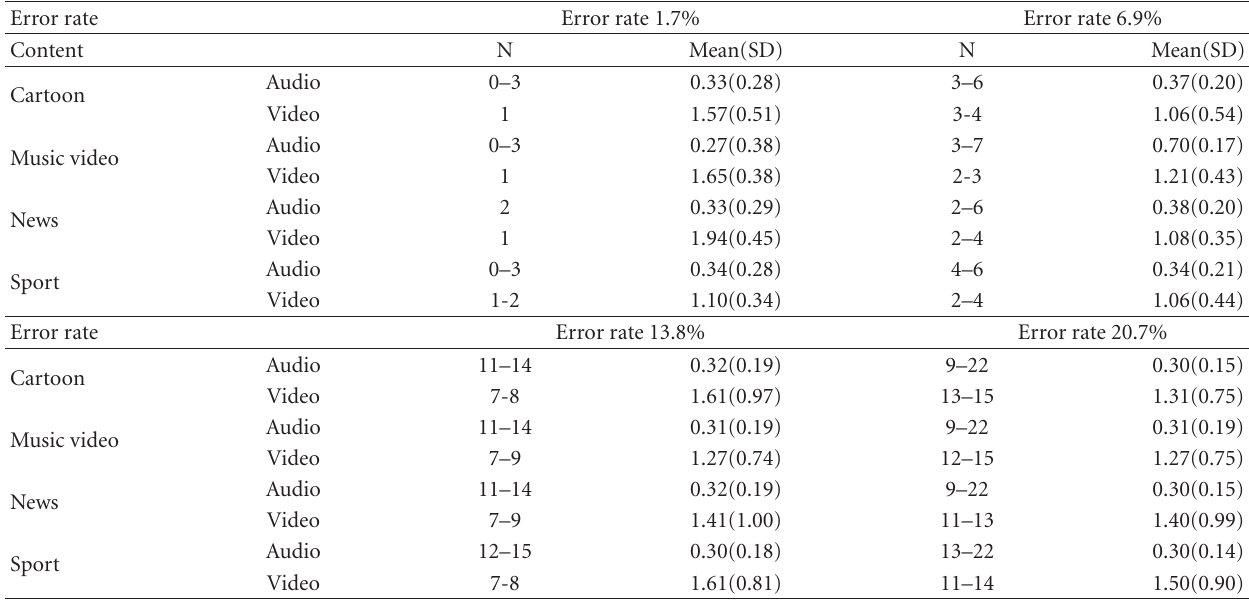
Table 2: Number of errors, mean durations, and standard deviation (in seconds) of burst errors for error patterns in di ff erent error